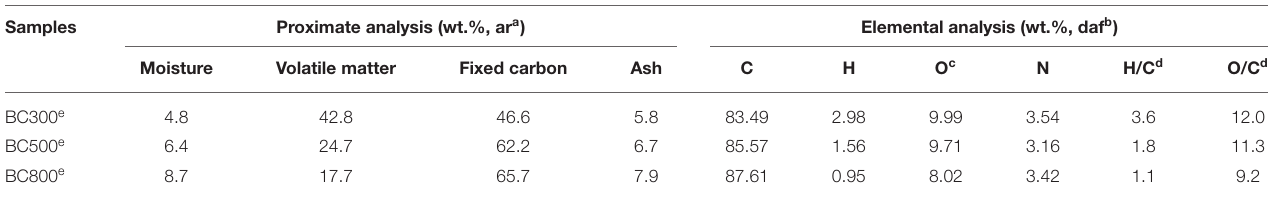
TABLE 1 | Proximate and elemental analysis of biochar samples.